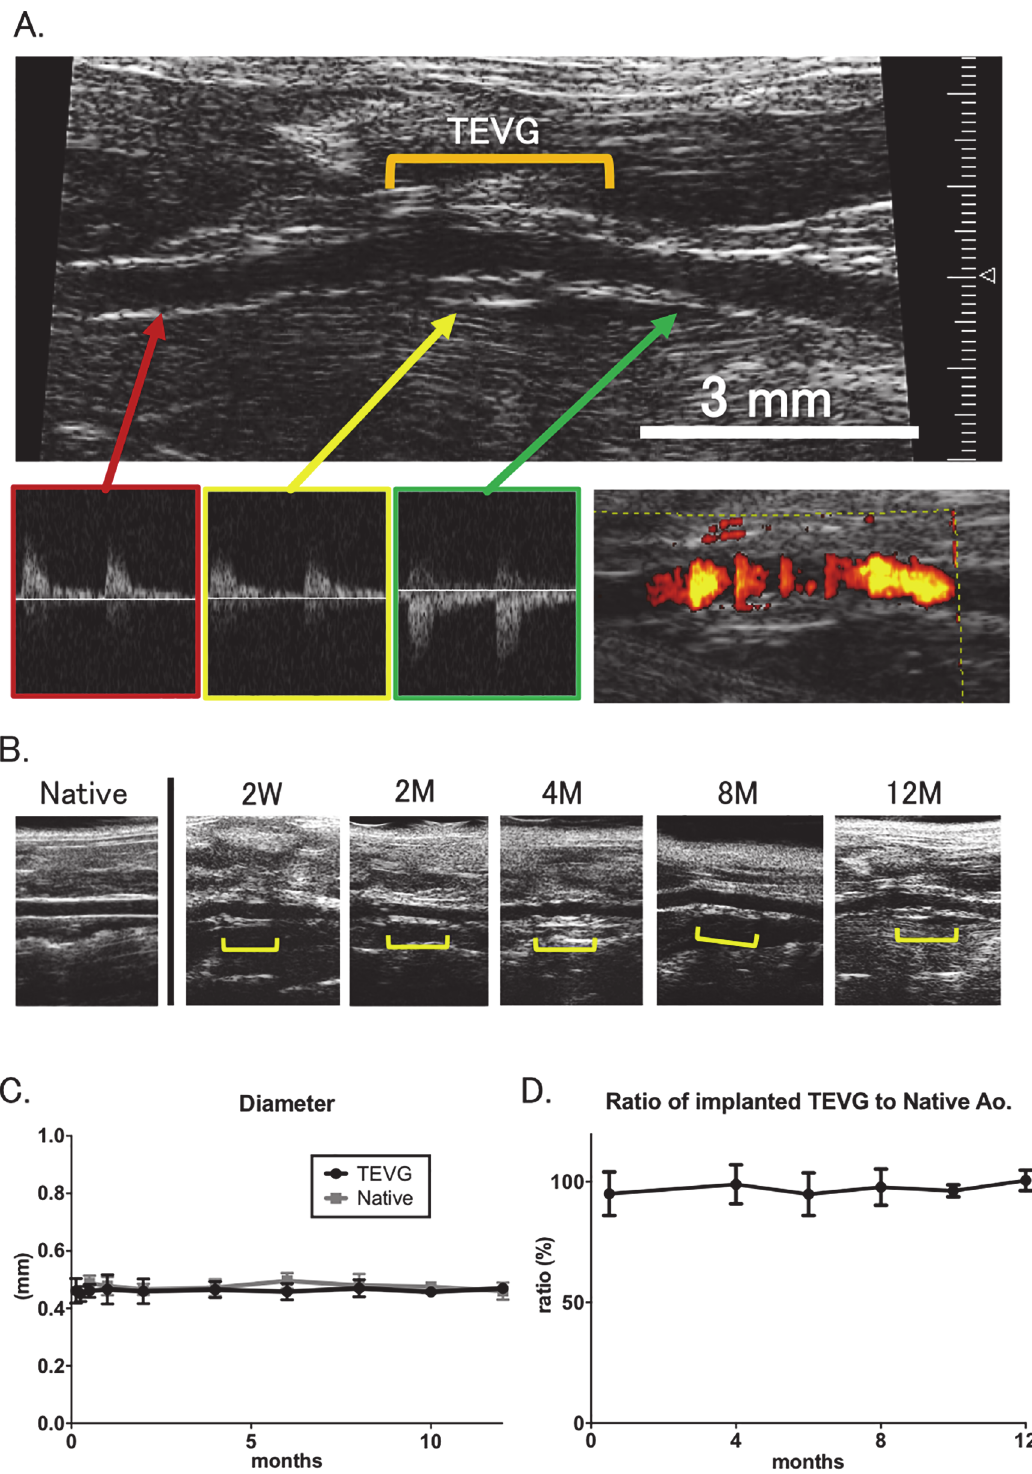
Fig 2. Luminal patency and laminar flow were similar between TEVG and native aorta over the course of the 12 month experiment. A . Doppler ultrasound examinations were performed on tissue engineered vascular grafts from 2 weeks to 12 months after implantation. Doppler signals proximal to the graft, distal, and within the graft showed propagation of systemic arterial impulse through the graft. B. In vivo microCTs were performed at 4, 8, and 12 months. Using image analysis software, luminal volume measurements were recorded and then standardized to a 3mm segment. C. & D. When compared to